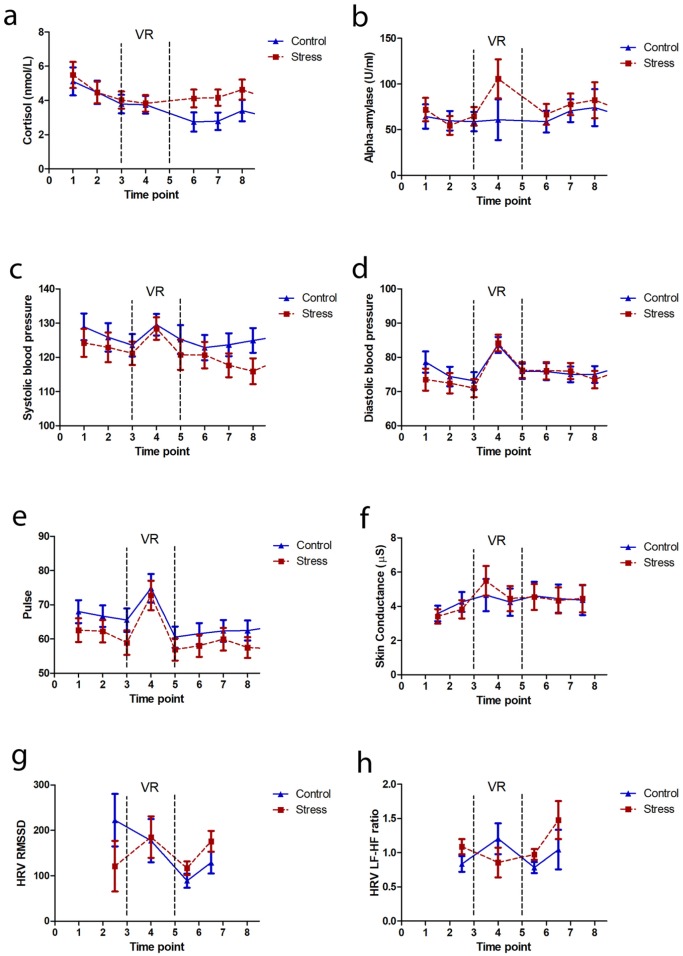
Variation in physiological stress indices across the experimental time
course. Changes in (a) cortisol, (b) alpha-amylase, (c) systolic blood
pressure, (d) diastolic blood pressure, (e) pulse rate, (f) skin
conductance, (g) heart rate variability RMSSD and (h) LF-HF ratio
measures over the course of the experiment in those randomised to the
control (blue triangles and solid lines) and stress (red squares and
dashed lines) elevator. Vertical dashed lines indicate the period that
participants were immersed in the VR environment (i.e. from just after
time point 3 to just before time point 5).